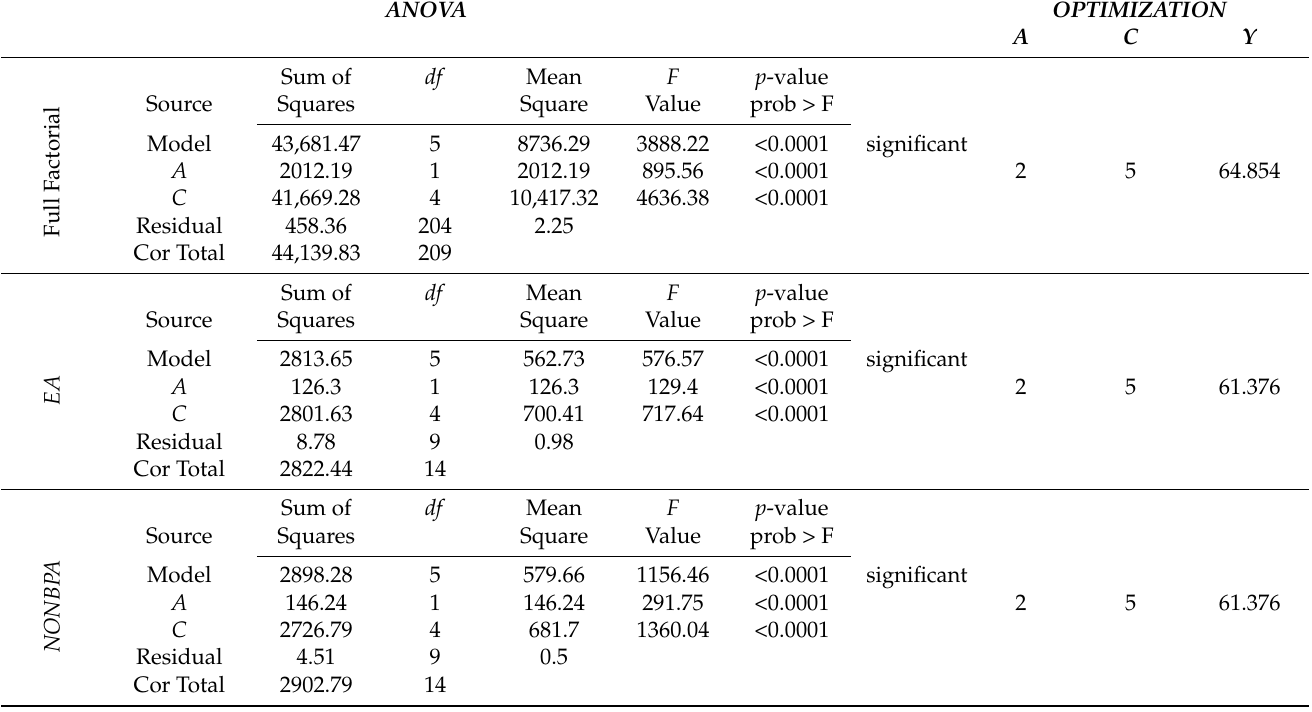
Table 6. ANOVA tables and optimization for full factorial, EA , and NONBPA